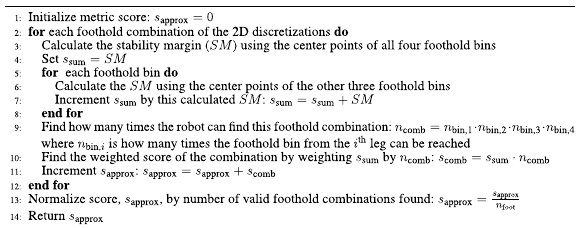
Algorithm 2. Average Static Stability Criteria Approximation Calculation